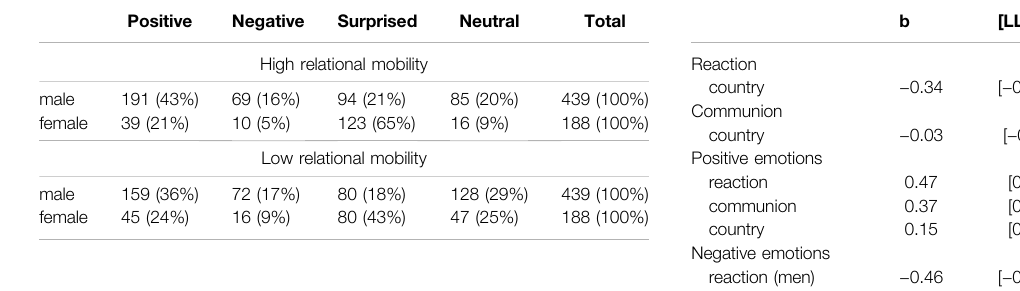
TABLE 3 | Frequencies of categories of reactions to scenarios. TABLE 4 | Direct effects in modi fi ed path model.